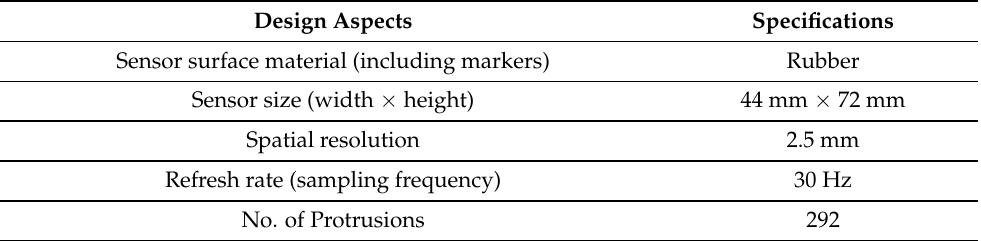
Table 2. Design aspects and specifications of the tactile fingertip